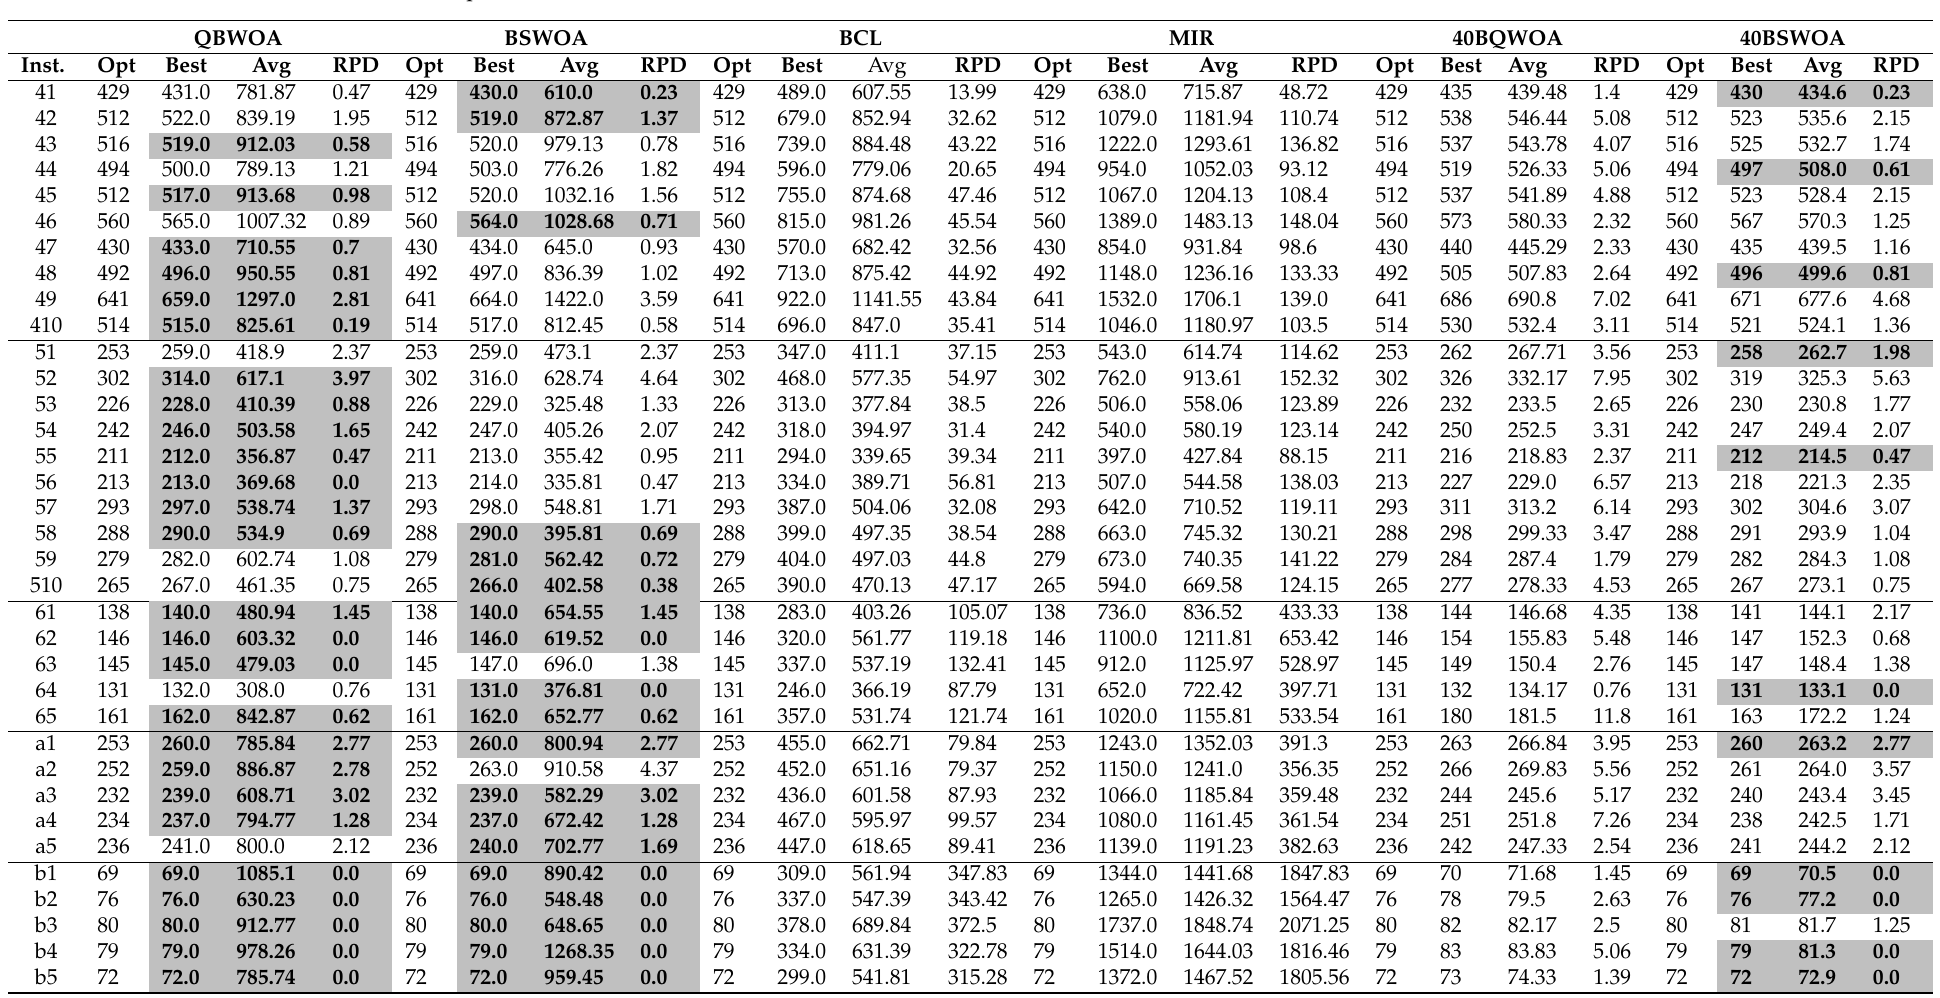
Table 4. Comparison of the metaheuristics